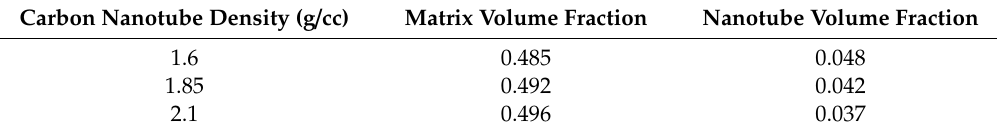
Table 2. The matrix and nanotube volume fractions for samples based on a range of carbon nanotube